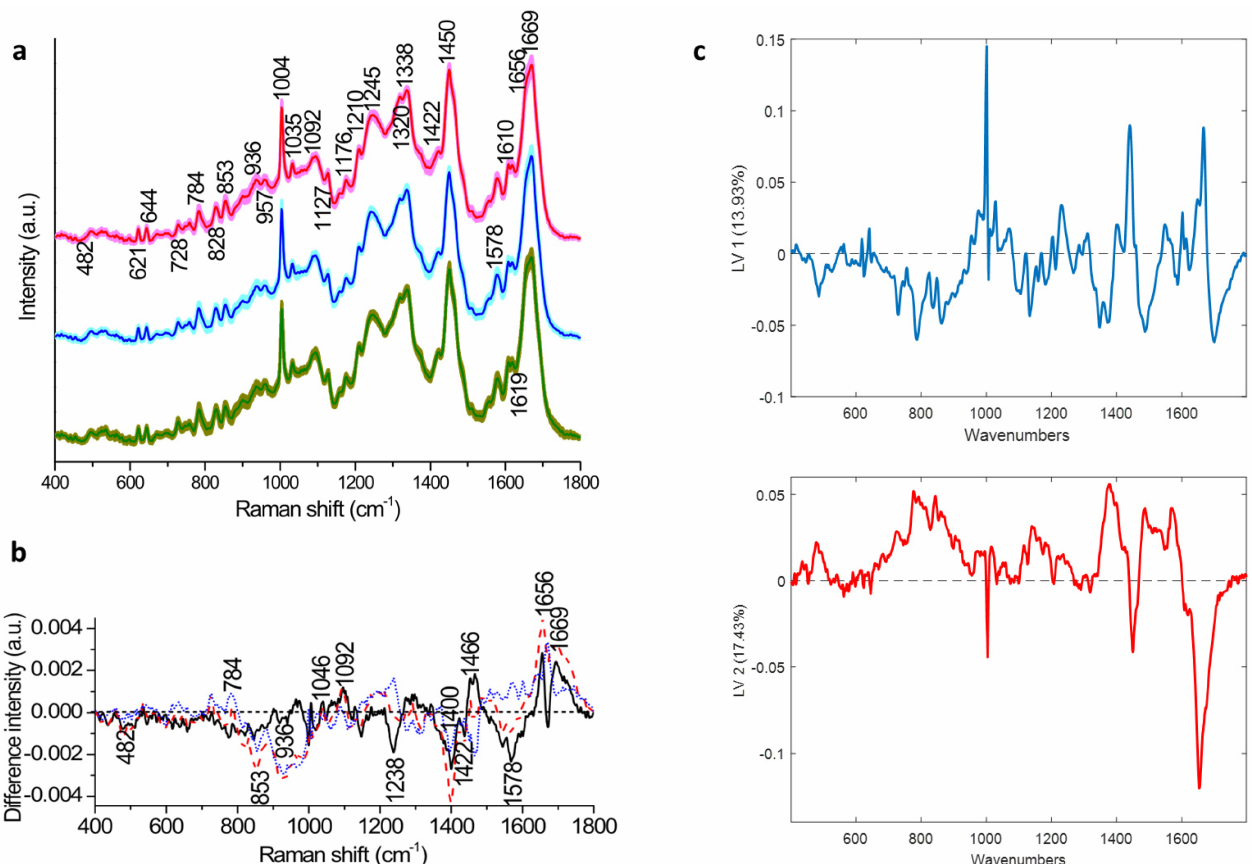
Figure 2. ( a ) Mean Raman spectra of negative (green), CIN1 (blue) and CIN2+ (red) samples; shading indicates the standard deviation; ( b ) Different Raman spectra of negative (CIN1) (black), negative (CIN2+) (red), and CIN1-CIN2+ (blue); ( c ) partial least squares (PLS) and latent variables (LV1 and LV2) of the PLS-DA model developed from the training